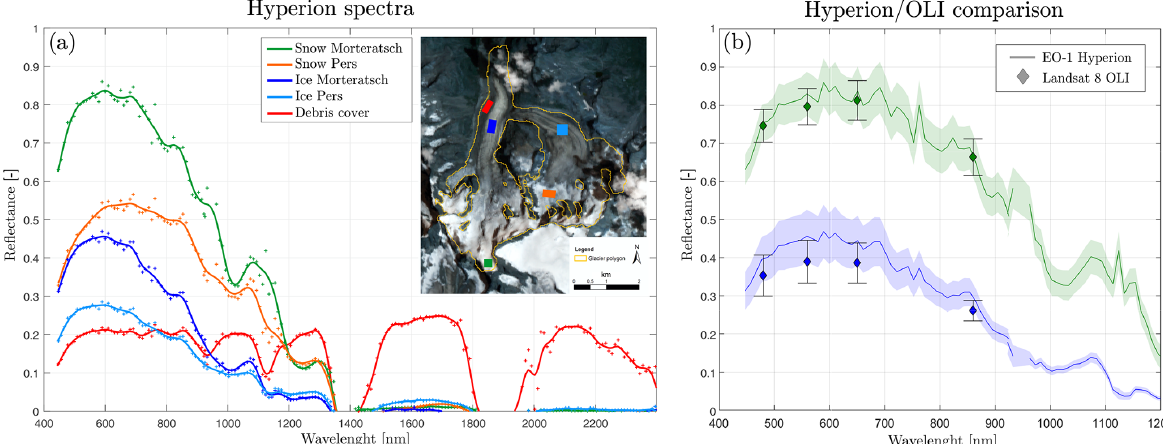
Figure 6. (a) Reflectance spectra of the Morteratsch Glacier extracted from the Hyperion scene. Solid lines are smoothed reflectance with a Savitzky–Golay filter in order to remove the noise. (b) Comparison between Landsat 8 OLI bands (diamonds) and EO-1 Hyperion spectra (solid lines) for the ablation (blue) and accumulation (green) zone. Error bars and shaded bands represent the standard deviation of the selected